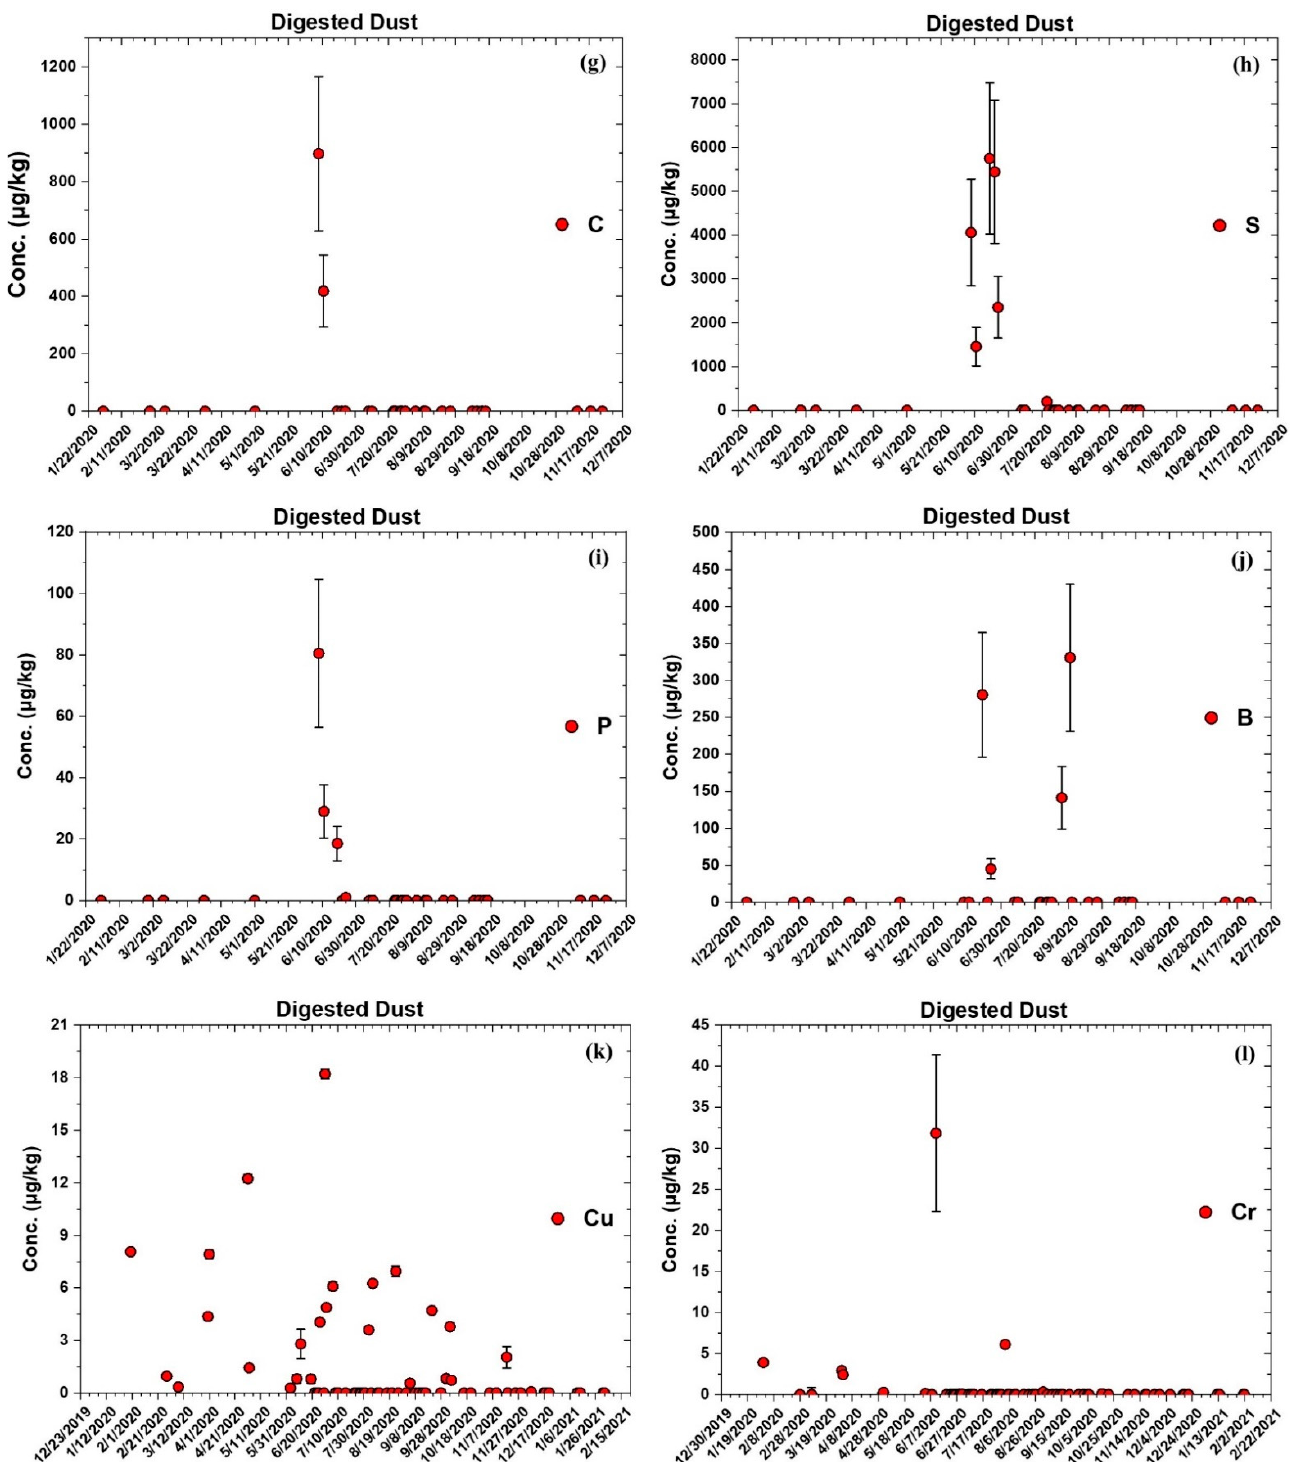
Figure 4. Composition of dust including concentrations of Fe, Si, Al, K, Ca, and Mg measured using bulk digestion and ICP-MS measurements of samples collected throughout the year. Note that where the error bars cannot be seen, they are very small relative to the concentration.